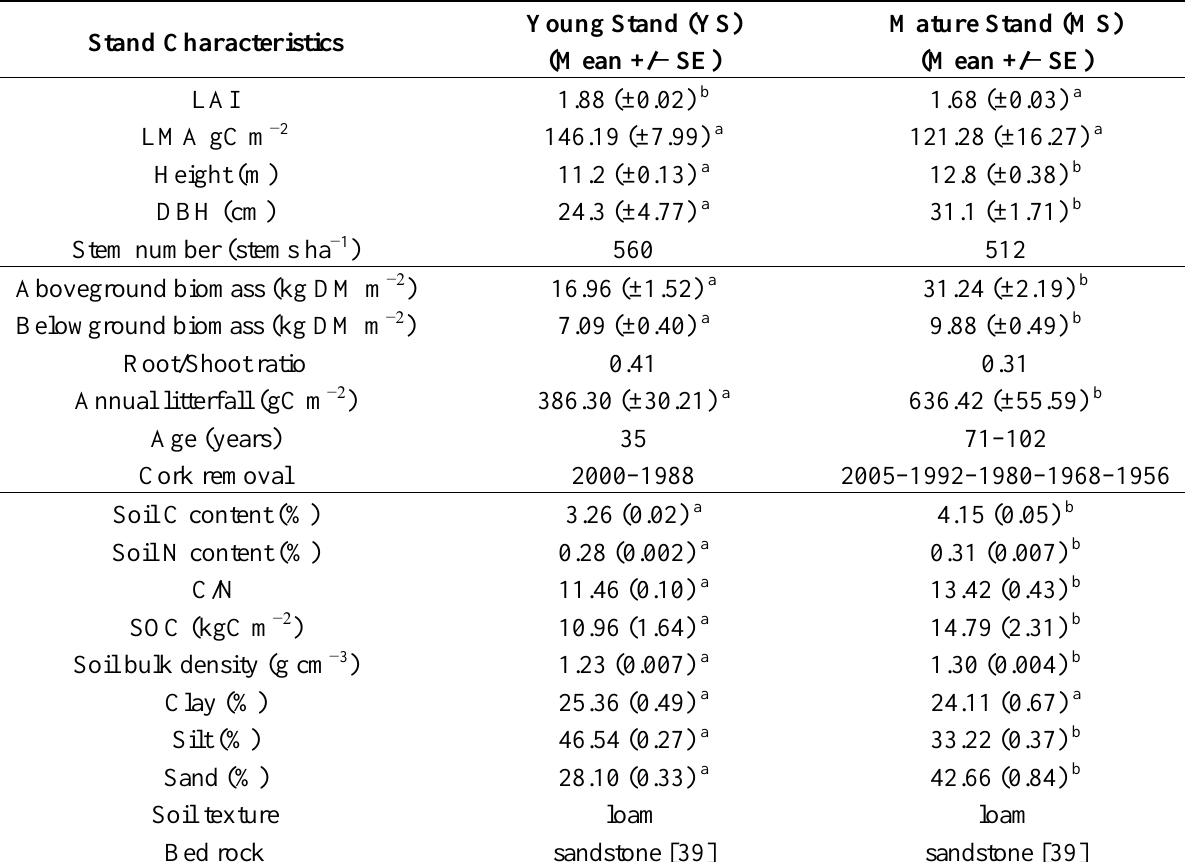
Table 2. Stand characteristics for aboveground vegetation and soil chemical and physical properties of the topsoil layer (30 cm) in the young (YS) and the mature (MS) forests of Quercus suber in the Bellif study site.